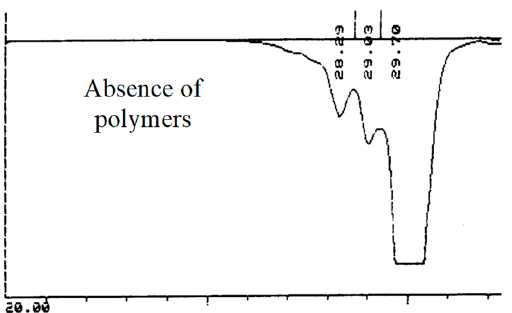
Figure 6. SEC chromatogram (in DMF with a refractive index detector) of the acetylated telomers mixture obtained by telomerisation of VDF with 2-mercaptoethanol (initiated by di-t-butyl peroxide, initial [CTA] 0 /[VDF] 0 molar ratio of 0.1) and acetonitrile as the solvent, at 140 °C, reaction times: 30 min).